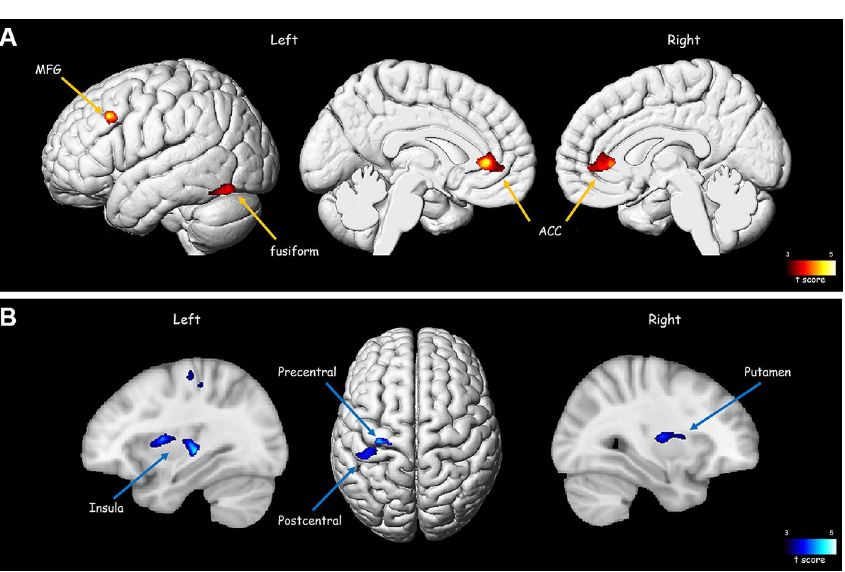
Figure 3. Illustrations of brain areas with significant grey matter volume differences between the higher and lower MI groups on VBM analysis. ( A ). Red areas represent higher volume in the higher MI group. ( B ). Blue areas represent higher volume in the lower MI group. ( p < 0.001, k > 300). ACC = anterior cingulate cortex, MFG = middle frontal gyrus, VBM = voxel-based